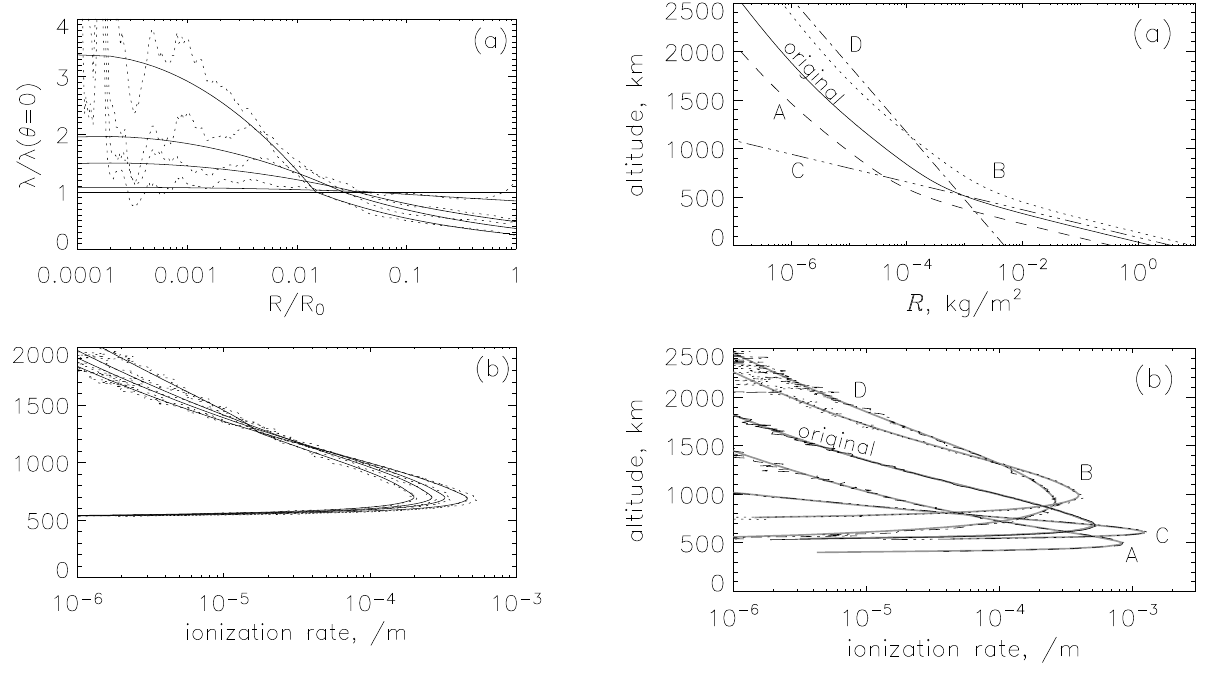
Figure 6: 2007.12.18: Y. Hiraki and C. Tao Fig. 6. Dependences of (a) parameter λ and (b) ionization rate on Figure 7: 2007.12.18: Y. Hiraki and C. Tao Fig. 7. Examples of the application of our parameterization to var- the tilt angle θ from the vertical line of initial electron velocity for ious cases of the H 2 density distribution (a) ; in (b) the solid and the cases of ε 0 = 10keV and θ = 30, 60, 70, and 80 degrees (dotted: dotted lines show the results from parameterization and from calcu- calculated, solid: parameterized by Eq. 6). For (a) the ratios to the lation, one of θ = 0 in Fig. 4 are shown. For (a) the deviation at R/R 0 < 0 . 01 increases and for (b) the magnitude at higher altitude increases (the peak decreases) with increasing θ , respectively.